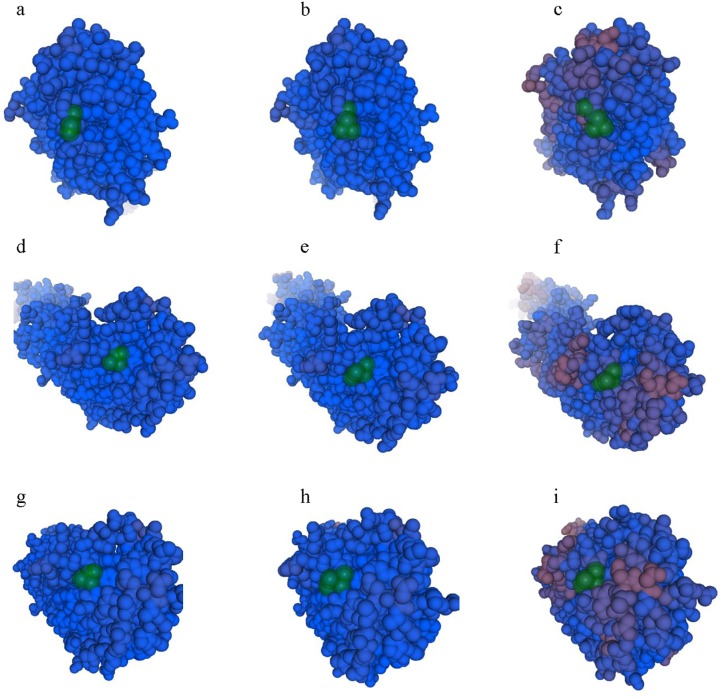
Spatial structures of HA1 belonging to the majorities of avian- and human-derived H7N9 AIVs and the transitional ones.The focused substitutions were labelled by deep green. a, d, and g are of the majority of avian-derived H7N9 AIVs, and the template for homology modelling was 4fqv (Identity 98.44%); b, e, and h are of the transitional ones, and the template for homology modelling was also 4fqv (Identity 98.13%); c, f, and i are of the majority of human-derived H7N9 AIVs, and the template for homology modelling was 5v2a (Identity 99.07%). a-c display the substitutions of site 128(136), while d-i displayed the substitutions of site 135(143) from two different perspectives. Other information refers to S1 File.